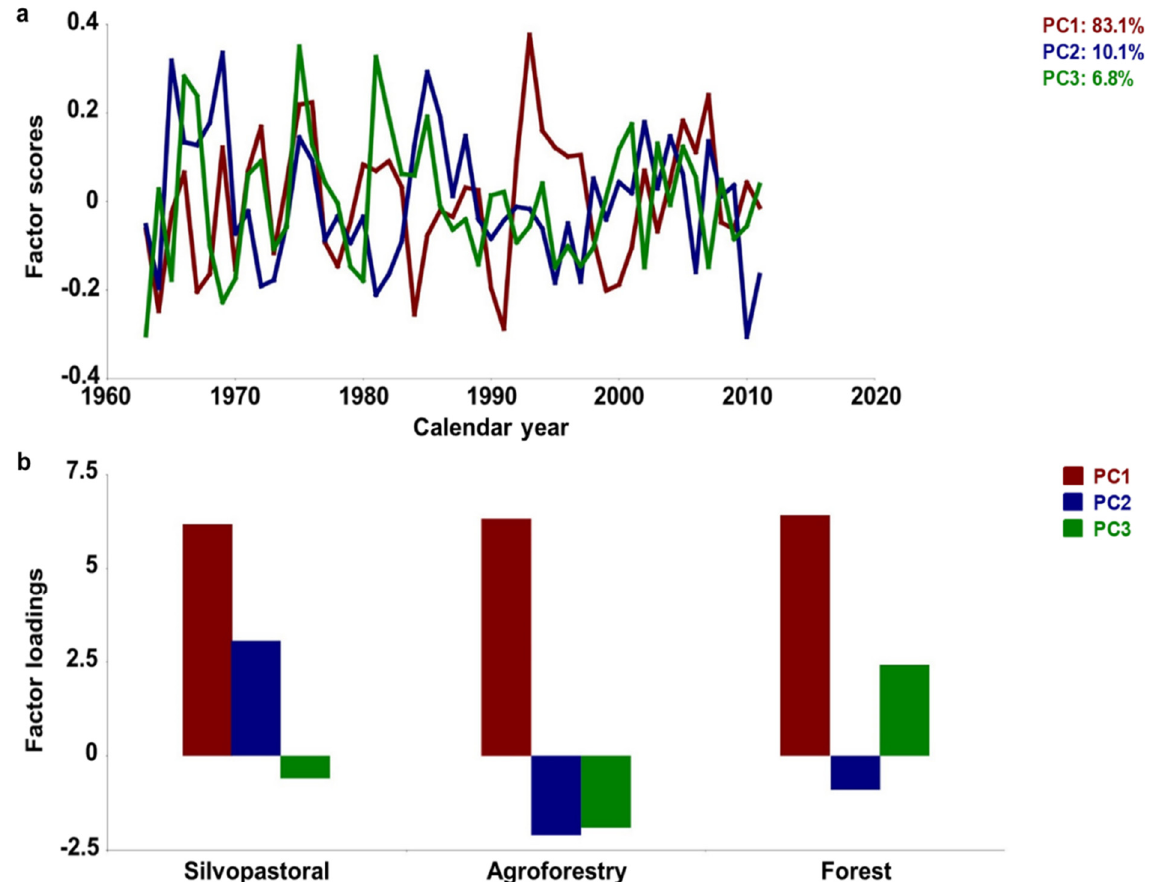
Figure 5. Results of the principal component analysis (PCA) for three TRW chronologies: ( a ) The line graph shows the time courses of the factor scores of PC1, PC2 and PC3; ( b ) the bar graph shows the factor loadings on PC1, PC2, and PC3 for the three chronologies.